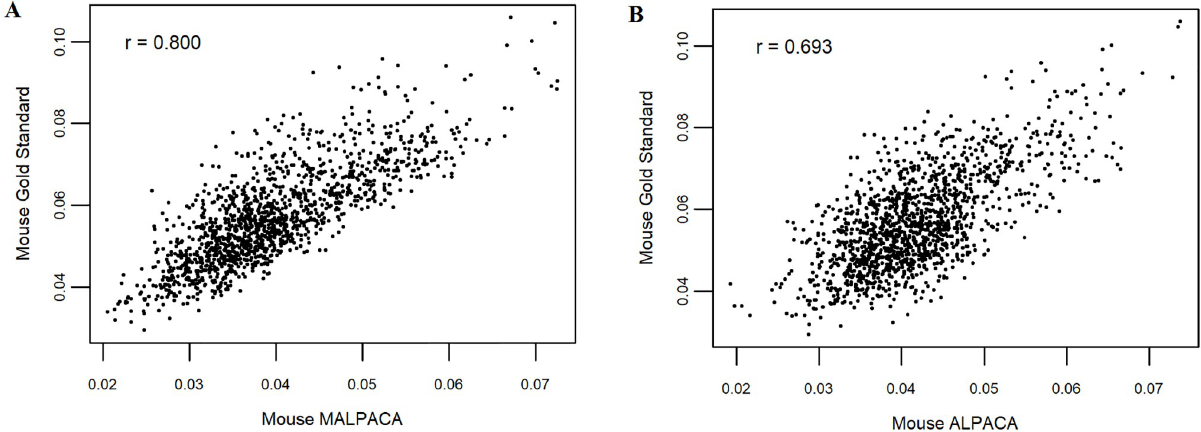
Fig 3. Comparison of the pairwise distances derived from the mouse estimated and GS landmarks. (A) MALPACA vs. GS. (B) ALPACA vs. GS based on the synthetic template. “r” = correlation coefficient. The plot is based on distances between all pairs of specimens within the mouse sample derived from separate GPA of estimated and GS landmarks.